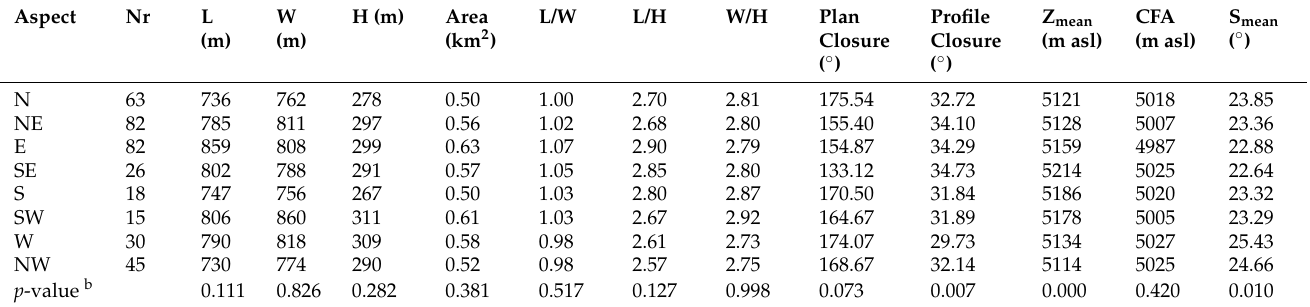
Table 4. Cirque metrics against aspect a .